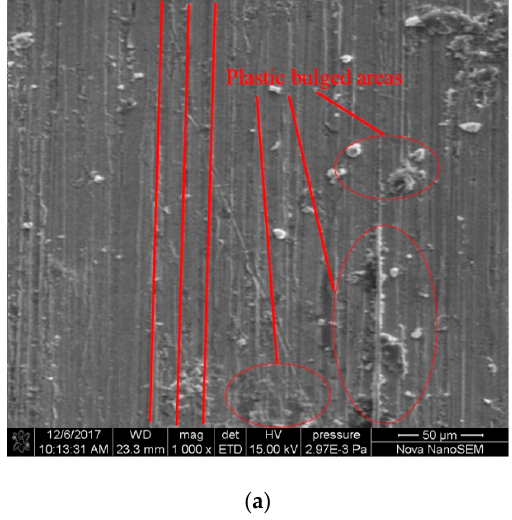
11 of 23 Figure 6. Electron microscope image of linear track grinding. ( a ): Test 1; ( b ): Test 6; ( c ): Test 7 As shown in Figure 7, under three different kinds of grinding trajectories, although the texture of the linear trajectory consistency was the highest and the texture was the most neat, it had relatively poor surface integrity, and its surface had certain defects, such as plastic bulges and burrs. When tracking the grinding of the circular-form surface, the surface integrity was better when compared to the linear trajectory for grinding, and it had almost no defects such as burrs, but its grinding grain was messy, with relatively poor consistency. There was also a small number of burrs on the ground surface of the Z-shaped track, whose surface integrity was between that of the two previous cases. It could be that this was caused by the dulling of the abrasive particles. In the process of grinding, especially under the pressure of a large grinding head, the abrasive particles were easy to blunt. In straight trajectory grinding, only two abrasive directions are involved in grinding. The grinding blunt abrasive cannot be replaced, which results in dulling of the grits and scraps that are unable to be removed from the material surface completely, thus producing grinding defects. Additionally, in circular trajectory, due to the motion direction and the abrasive belt grinding head in the direction of the feed, there was a change of direction angle, and the dulling grits could be replaced in a timely